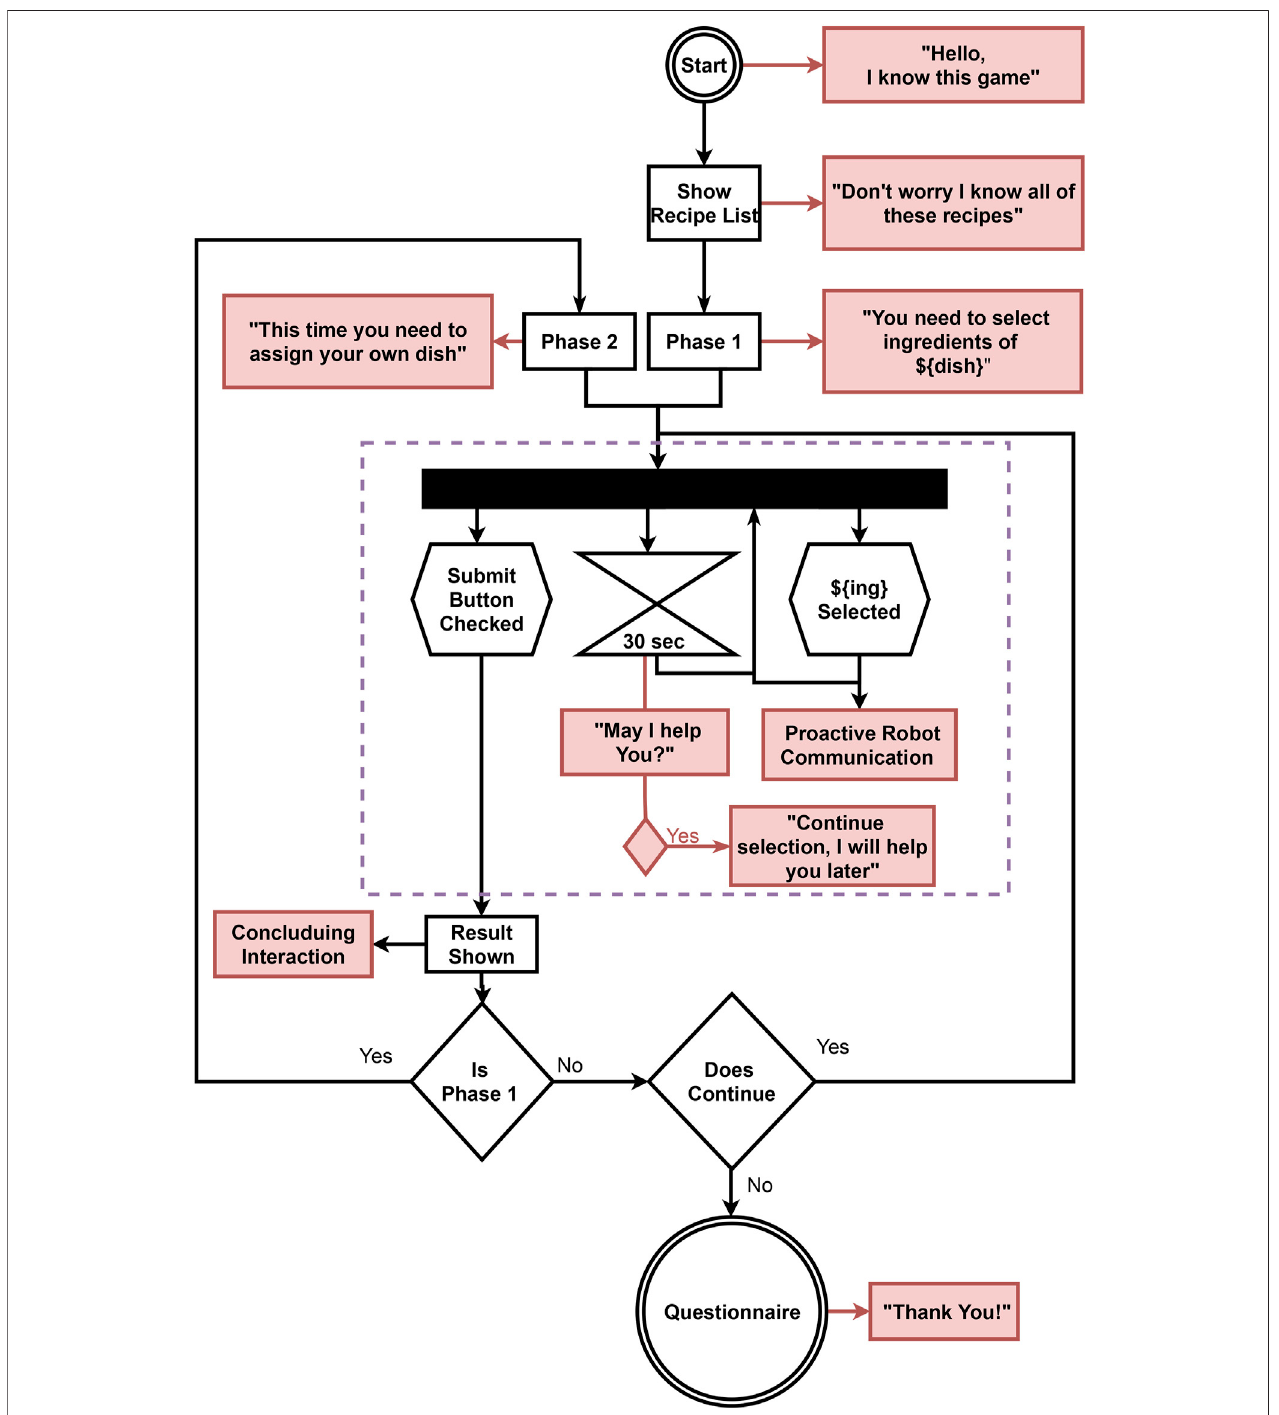
FIGURE1| Activity diagramofinteraction fl owindicates theactions ofthetask, therobot,and theuser.Blackrectangleboxes represent thepagesofthetaskand diamond boxes show the decisions of the task for general fl ow of phases. Robot responses are indicated with red boxes. Red boxes with black arrows represent the sentence that will be created. The user ’ s actions are represented with hexagon boxes.